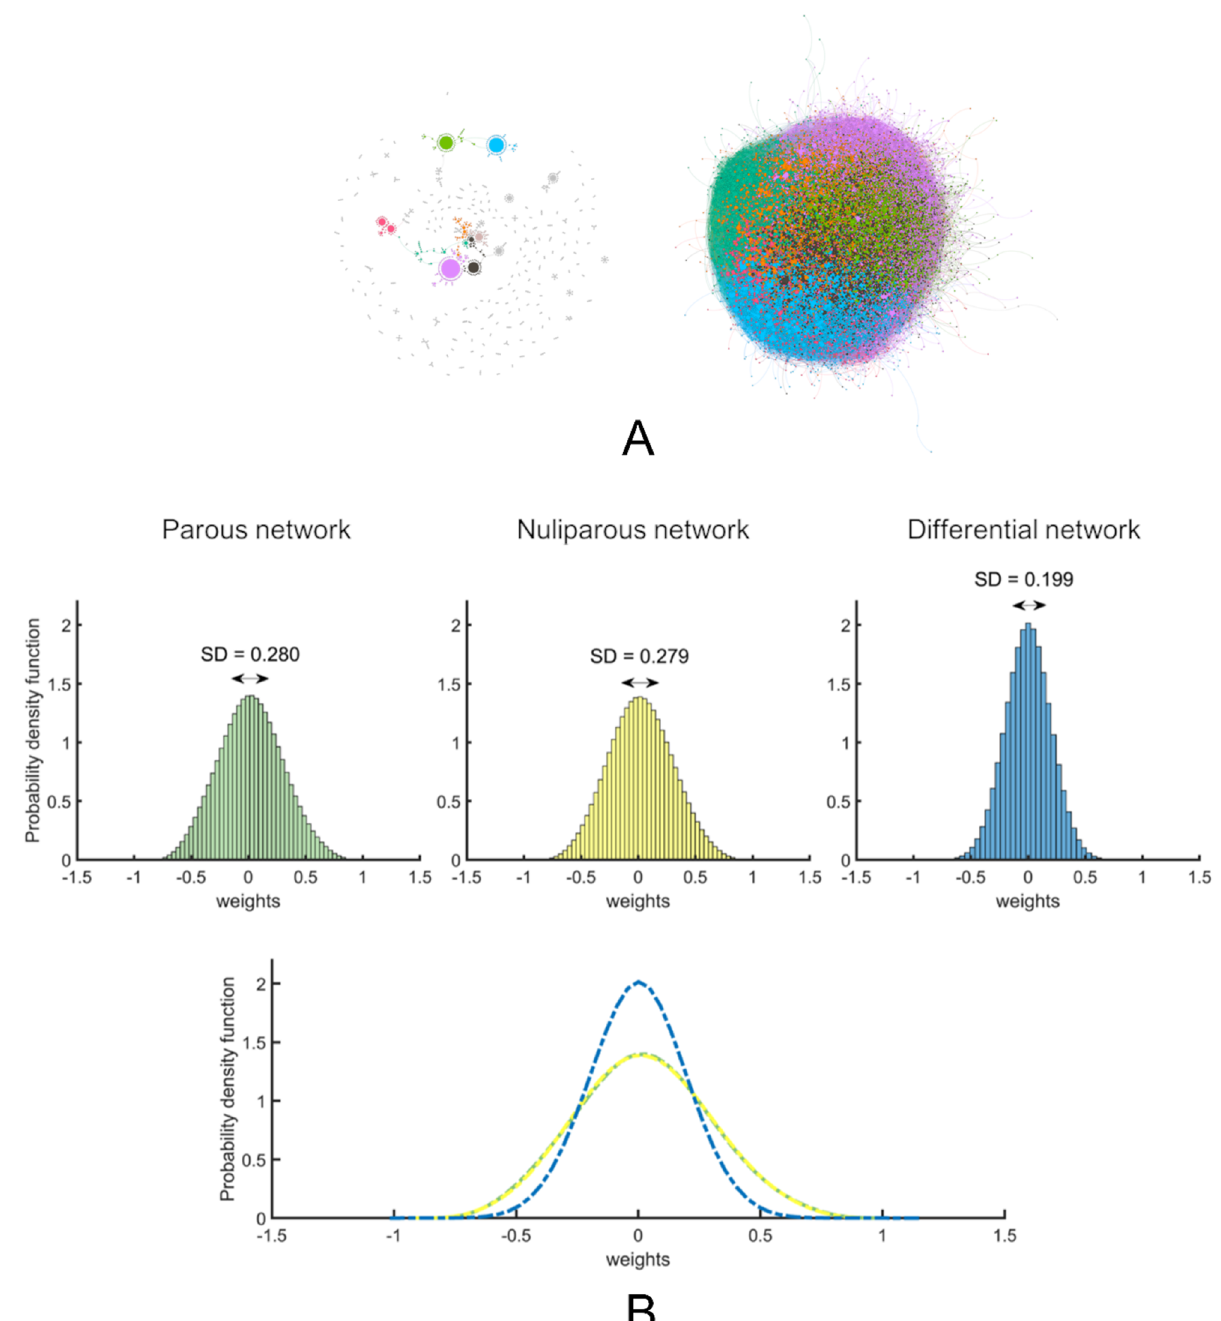
Figure 6. ( a ) Differential networks obtained from the direct comparison of parous and nulliparous groups depicted by ForceAtlas2 algorithm. For the figure on the left, the threshold of significance was set to α = 0.001, whereas α = 10 −6 for the network on the right. Different colors were assigned according to the cluster class obtained by the modularity measure (see Methods). The node size is proportional to the node degree (see Methods). ( b ): Probability density function (PDF) of the parous, nulliparous and differential networks. Parous and nulliparous networks show very similar distributions of the correlation weights. The differential network, however, is more compactly distributed despite having a larger range of possible values (from -2 to 2). The three PDFs are shown superimposed at the bottom, highlighting the greater compactness of the differential network (in blue). Values at the extremes of the differential network correspond to the connections (correlations) with highly significant differences between parous and nulliparous